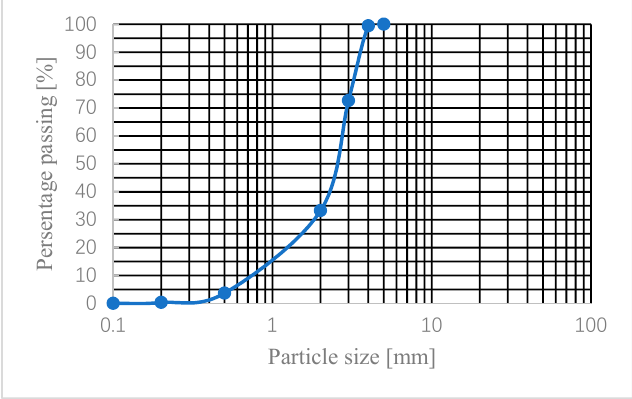
Figure 4. Standard sand average particle size gradation curve.